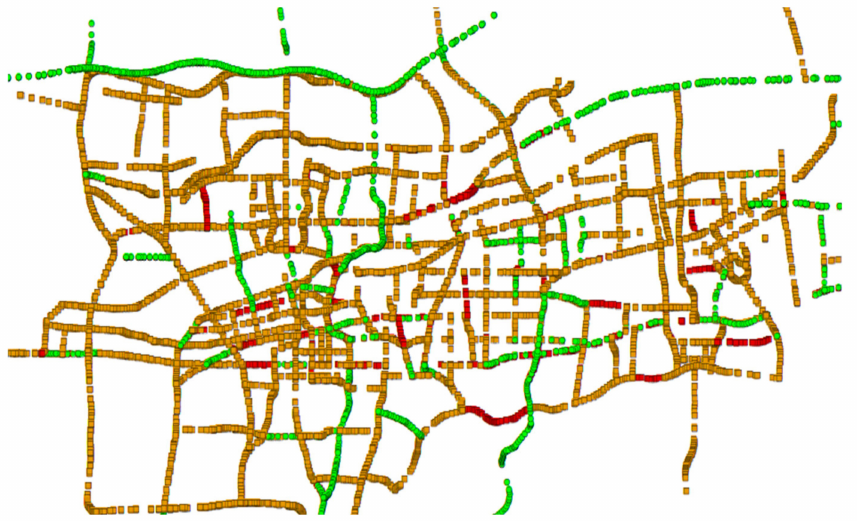
Figure 4. Road condition in the late morning rush hour in Jinan city. (The closer the road color is to green, the smoother the road. The closer the road color is to red, the more congested it is). In other time periods on weekdays, most of the road network traffic in Jinan is smooth. Only in the sections from Jiluo Road to Chengfengqiao and Lishan Road, was the situation red. The traffic network in this area was seriously congested, and the vehicle speed was very slow, as shown in Figure